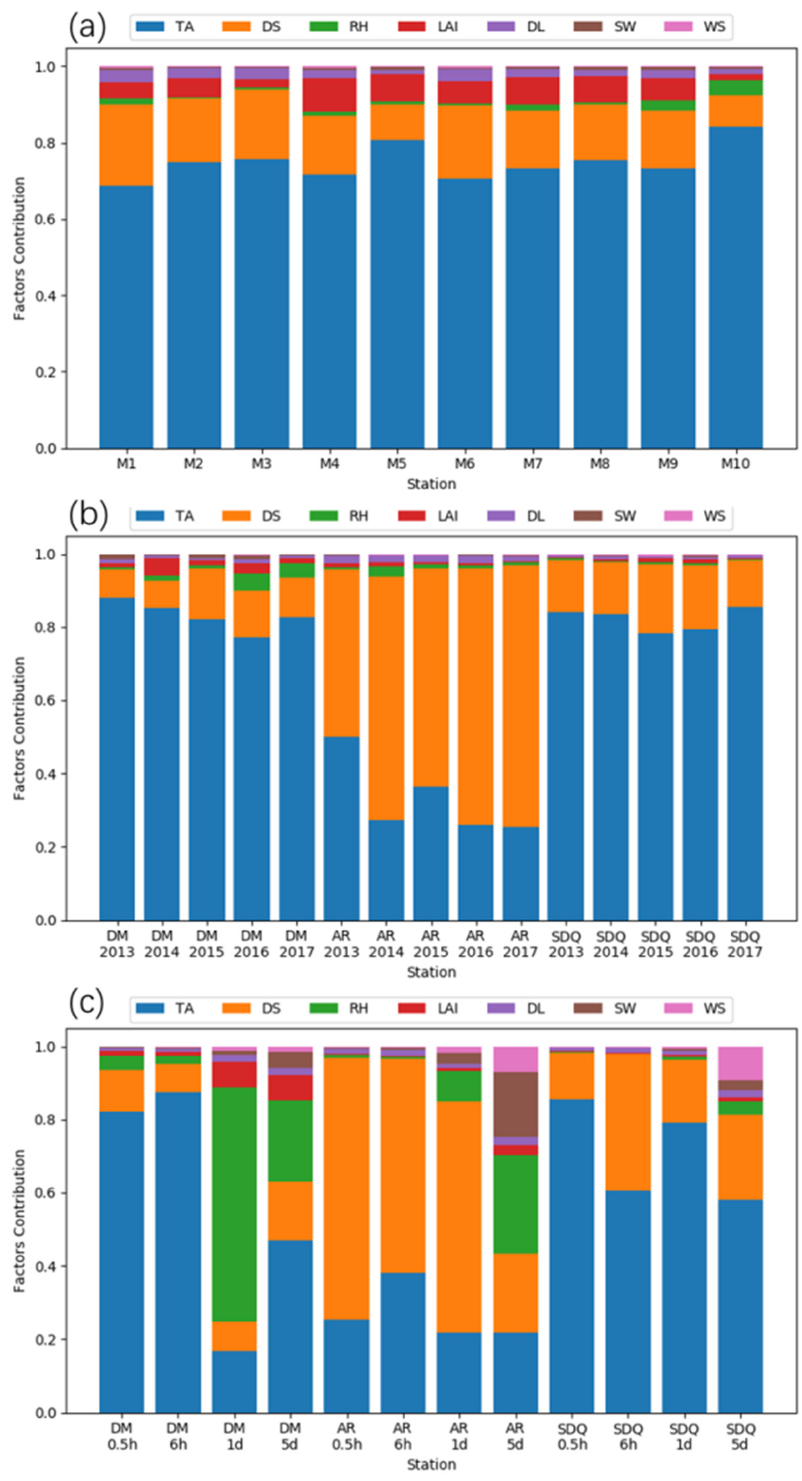
Figure 12. The contributions of inputs on predicting results by RF regression method for cases with ( a ) the same surface type, ( b ) different surface types, and ( c ) different time intervals. TA, DS, RH, LAI, DL, SW, and WS represent air temperature, downward shortwave radiation, relative humidity, leaf area index, downward longwave radiation, soil water content, and wind speed, respectively.